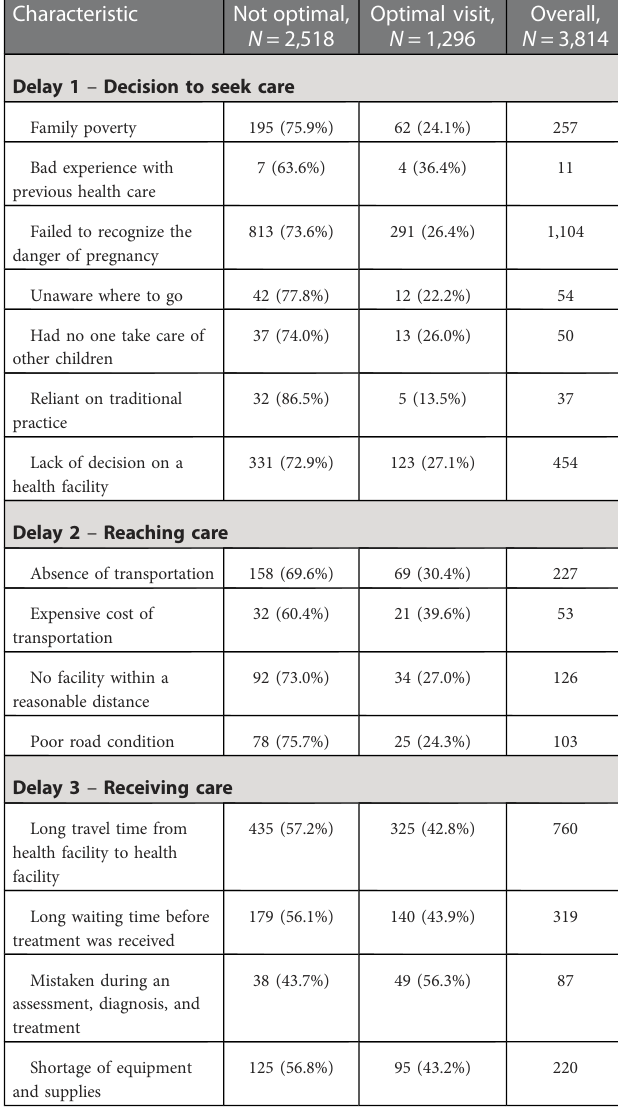
TABLE 6 Delay factors by the level of ANC follow-up in Ethiopia,